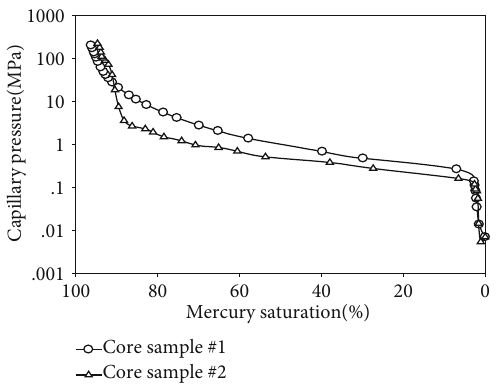
Figure 2: Capillary pressure curves of the two groups of rock